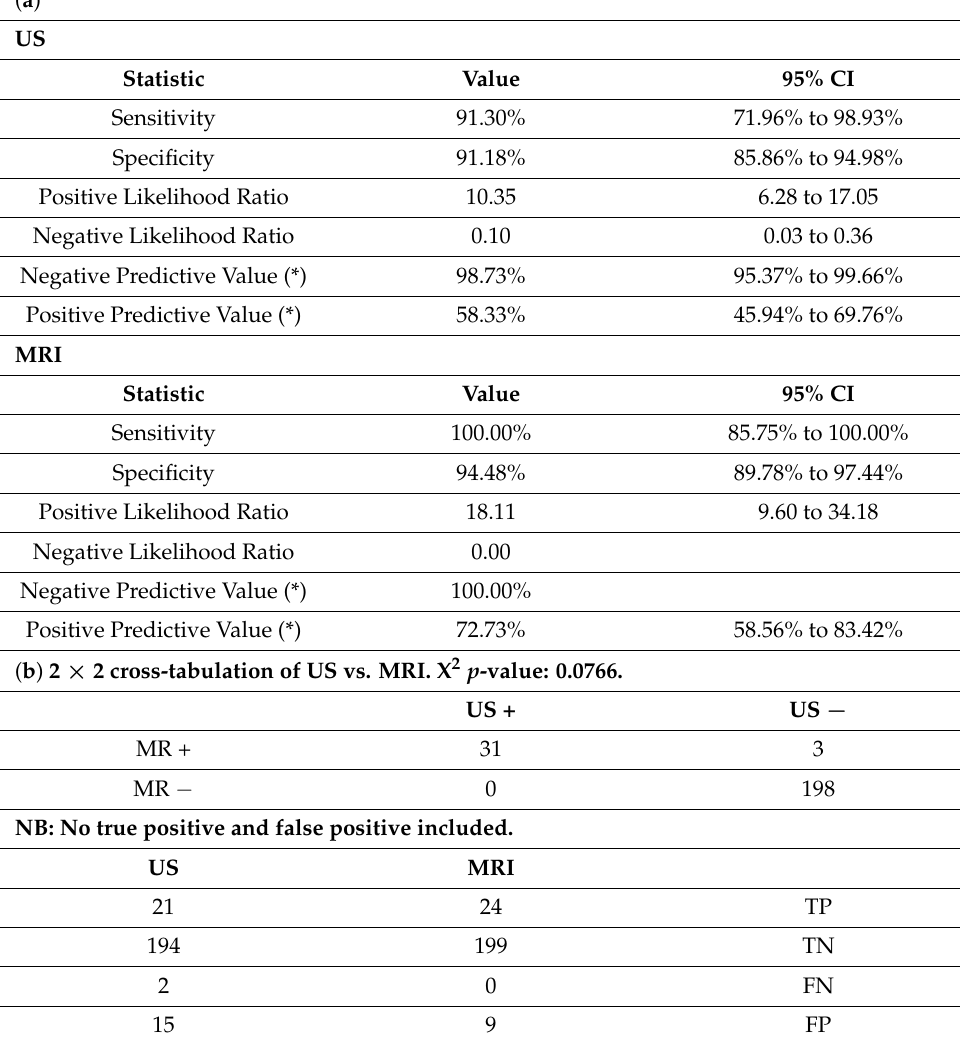
Figure 6. ROC analysis of US and MR imaging follow-up. Table 2. ( a ) Summary of diagnostic accuracy parameters for US and MRI. ( b ) 2 × 2 cross-tabulation with number of positive and negative scans. TP = true positive, TN, true negative, FN = false negative, FP = false positive. (*) These values are dependent on disease